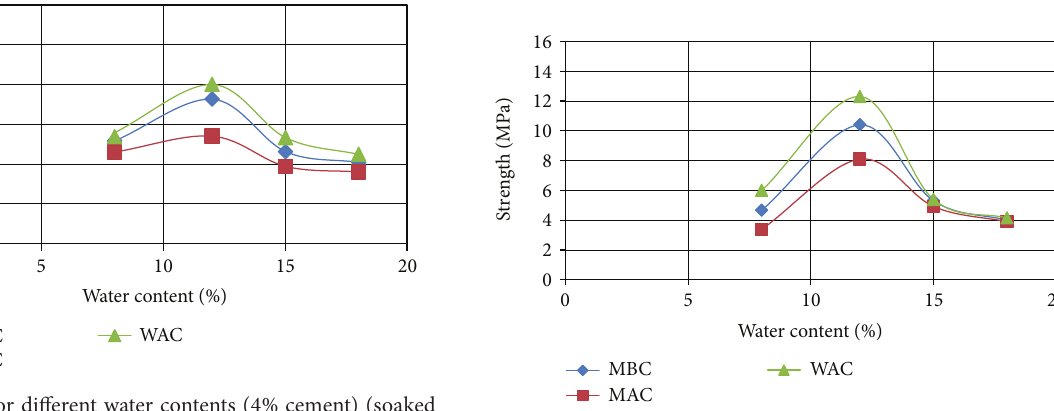
Figure 20: UCS for different water contents (12% cement) (soaked durability